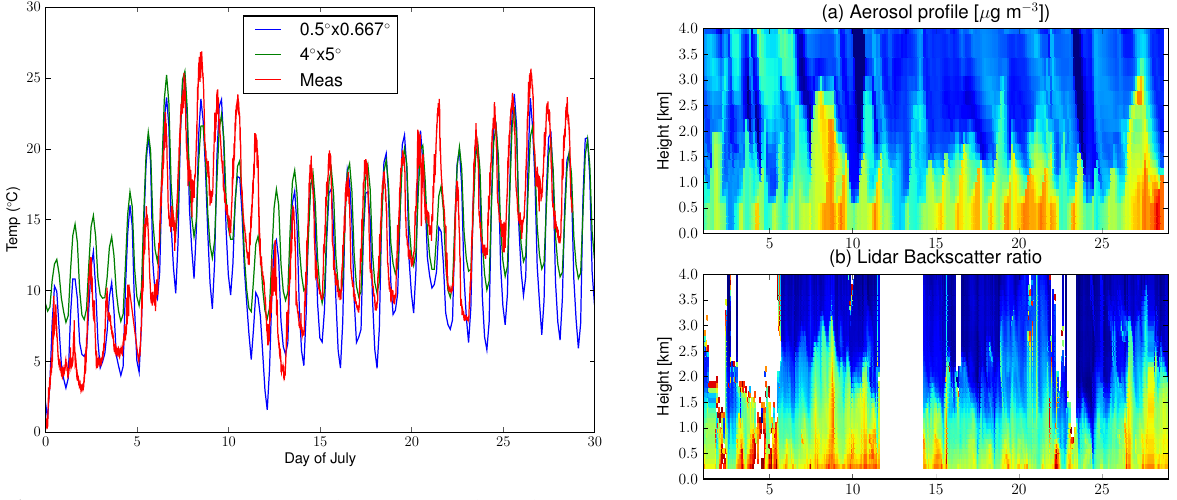
Fig. 2. Temperature at Raven’s Nest for the month of July for mea- sured and simulated data. The time is UTC.